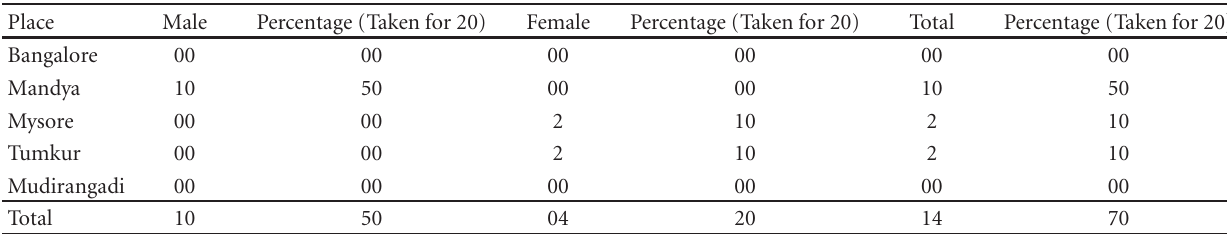
Table 3: Endemicity of brucellosis in South Karnataka.